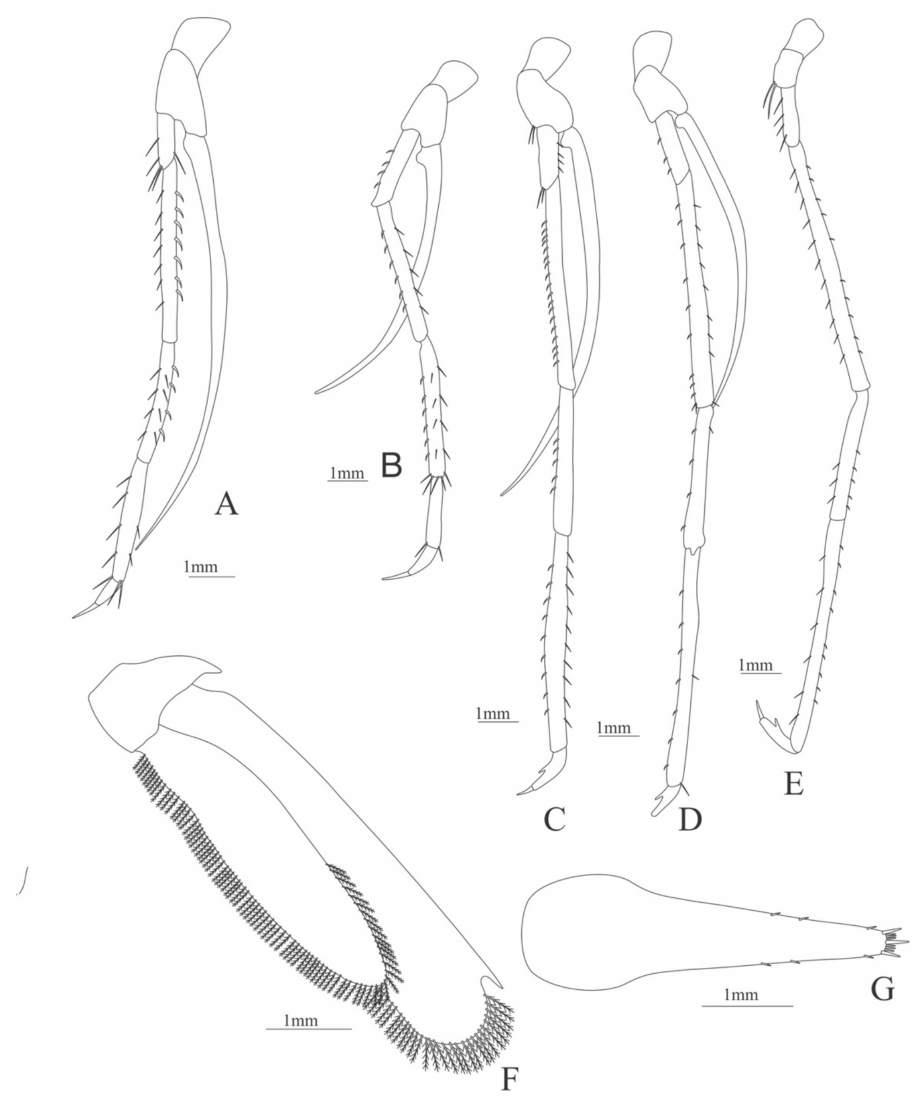
Figure 22. Plesionika edwardsii : ( A ) first pereopod; ( B ) second pereopod; ( C ) third pereopod; ( D ) fourth pereopod; ( E ) fifth pereopod; ( F ) telson; ( G ) Uropods. Juvenile. Size. 12 mm (Carapace length); 36 mm (Total length). N = 4. Carapace (Figure 23A). Rostrum long, slender, with 3 basal spines, slightly curved upwards and longer than antennular peduncle; antennal spine present; eyes pedunculate. Pleon (Figure 23A) with 6 somites, no spines or setae. Pleopods 3–4 missing in the specimen, pleopods 1–2 and 5 well